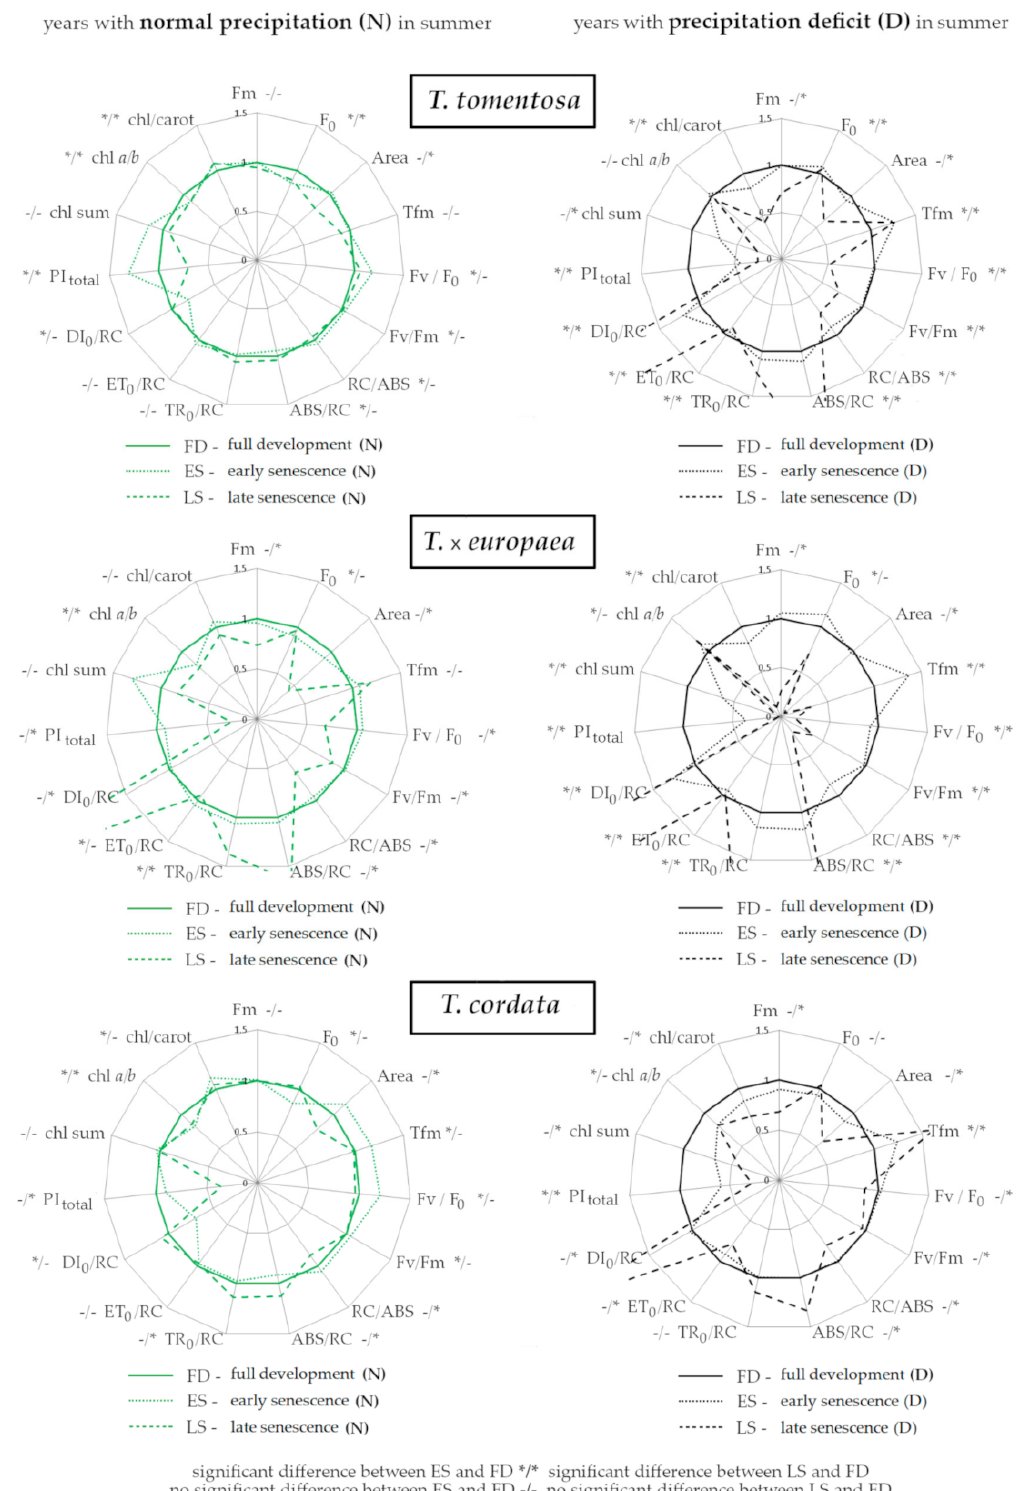
Figure 4. JIP-test and photosynthetic pigment parameters, calculated for investigated Tilia species presented as a spider plot. Fully developed leaves were set as 1, and early and late senescence presented in relation to fully developed leaves. Statistical analysis was performed separately to distinguish statistical differences between early senescence and full development (first mark), and late senescence and full development (second mark; − means there were no statistical differences, * means there were statistical differences according to the Kruskal–Wallis method and Dunn test with p <